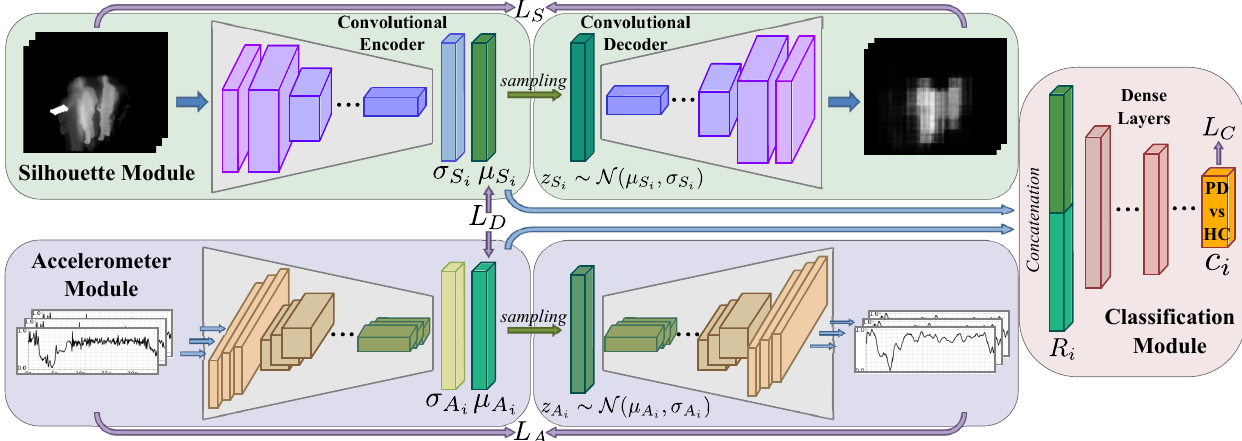
Figure 2. MCPD-Net: our proposed network consists of three modules: silhouette, accelerometer, and classification. Representations learned in the two former modules are fused in the latter module, for PD vs. HC